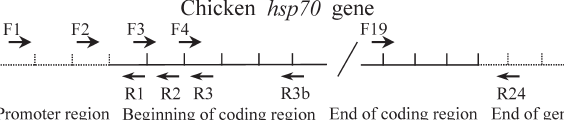
Figure 1 - Schematic representation of the position of the primers that were used in PCR-SSCP for detection of polymorphisms in the chicken hsp70